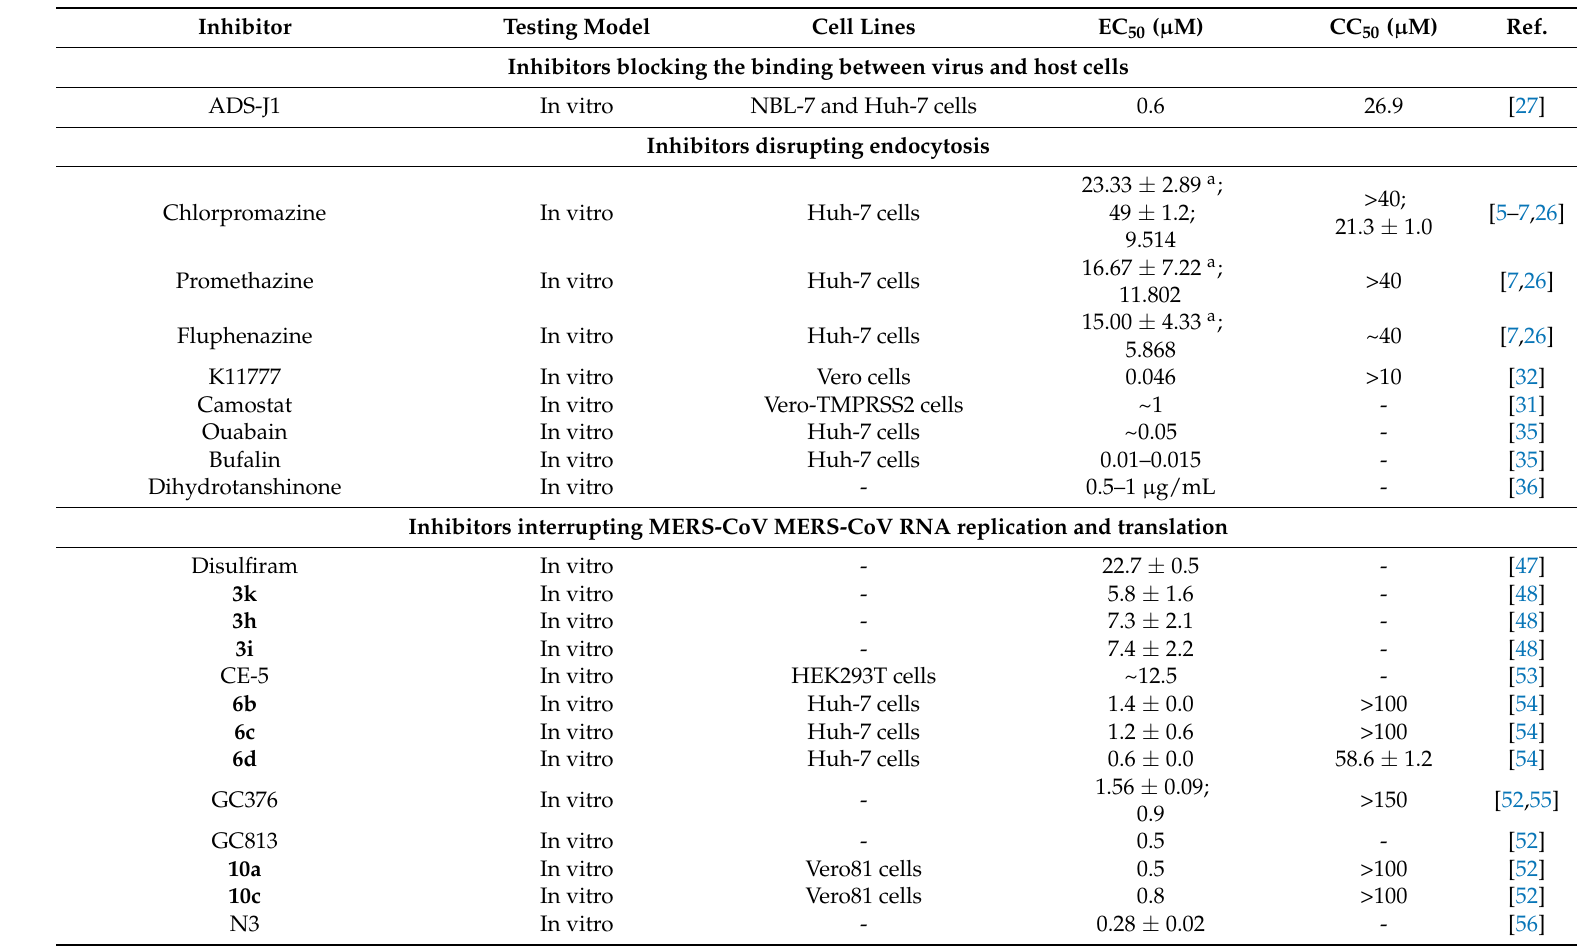
Table 2. Small molecule viral inhibitors against